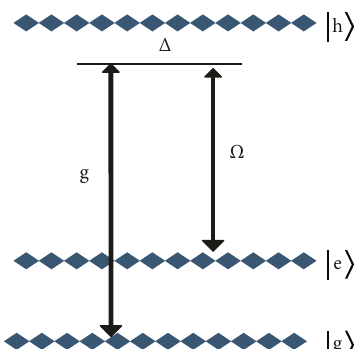
Figure 1: Schematic illustration of the Raman interaction of three-level Λ -type architectural finite element particles and cavity fields and laser